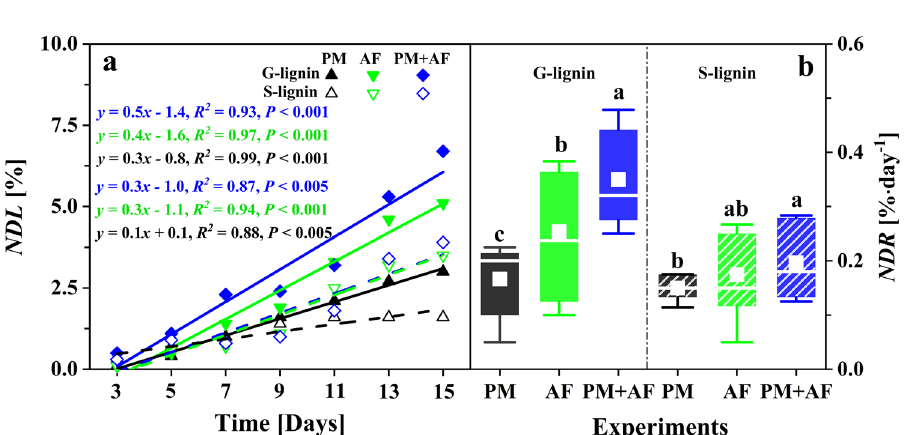
Figure 3. Net loss of guaiacyl monolignol (G-lignin) and syringyl monolignol (S-lignin) monomers in the three inoculation experiments: ( a ) net degradation loss ( NDL , the difference in lignin monomer contents between the inoculation experiments and the uninoculated control) and ( b ) net degradation loss rate ( NDR , the NDL at the end of the incubation divided by the duration of the incubation, in days). The equations and dashed lines represent the linear fit of the NDL versus time over the 15-day experiments. In the boxplots, white squares represent mean values, the horizontal lines represent median values, the boxes represent the 25th to the 75th percentiles, and whiskers represent the 95% confidence interval. Experiments: PM, Pseudomonas mandelii ; AF, Aspergillus fumigatus ; PM + AF, co-culture of the two microbes. Bars across all dates labelled with different letters differ significantly ( P < 0.05) between the four